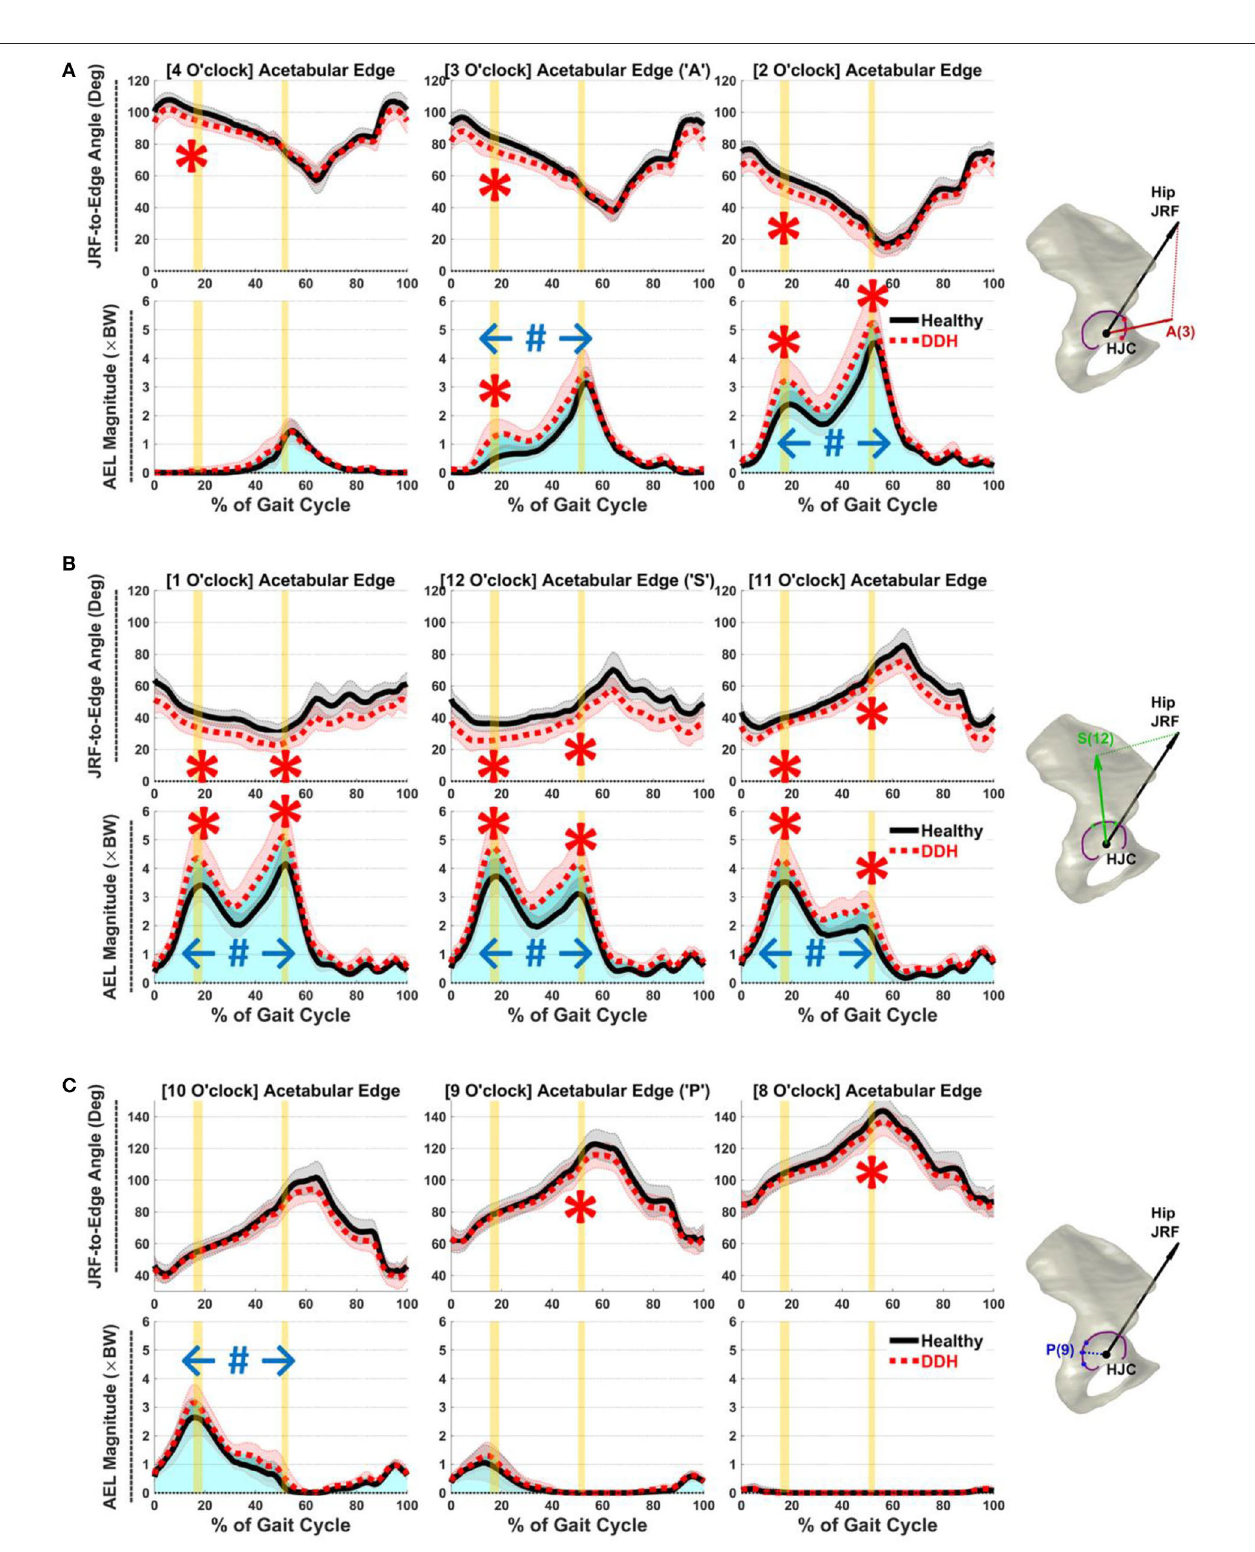
FIGURE 3 | Average JRF-to-edge angles (top) and AEL (bottom) in (A) anterior (2–4 o’clock), (B) superior (11–1 o’clock), and (C) posterior (8–10 o’clock) regions throughout gait. Red/black shades = ± 1 SD. Vertical yellow bars indicate time of JRF peaks (JRF1 and JRF2). Blue shades (total area under the curves) illustrate accumulative impulses. Statistical significance: “*” instantaneous, “#” accumulative.